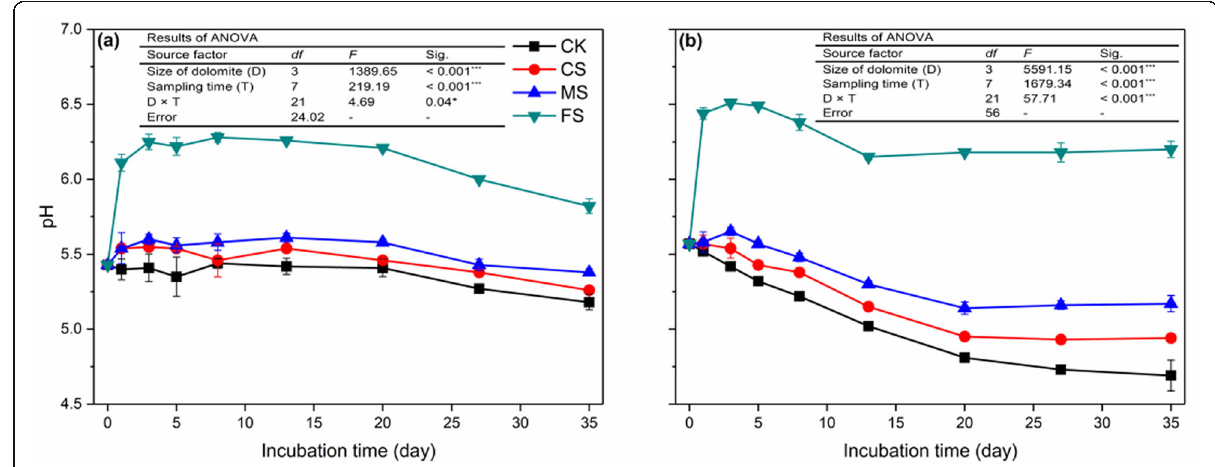
Fig. 1 Dynamics of soil pH in S1 ( a ) and S2 ( b ) as affected by different sized dolomite application. Error bars represent standard deviation of the mean values ( n = 3). CK presents soil without dolomite amendment; CS, MS, and FS present soil with the coarse-, medium-, and fine-sized dolomite amendment, respectively. *** P < 0.001, * P <